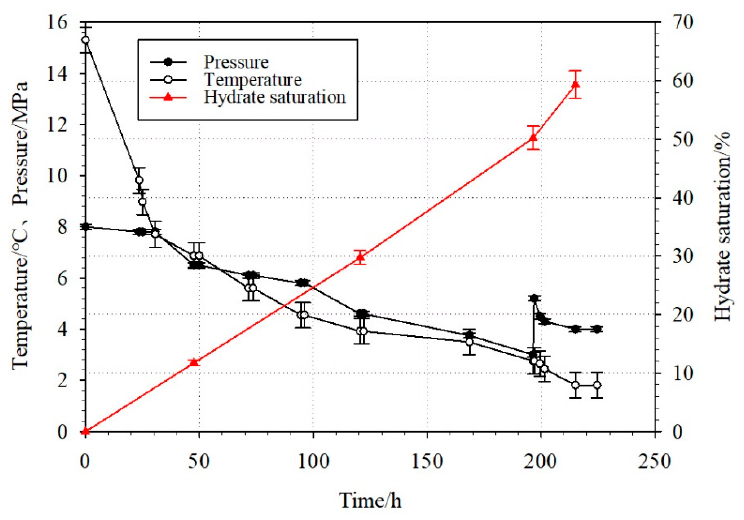
Figure 4. Variation in temperature, pressure, and hydrate saturation ( S h ) during hydrate for- mation.